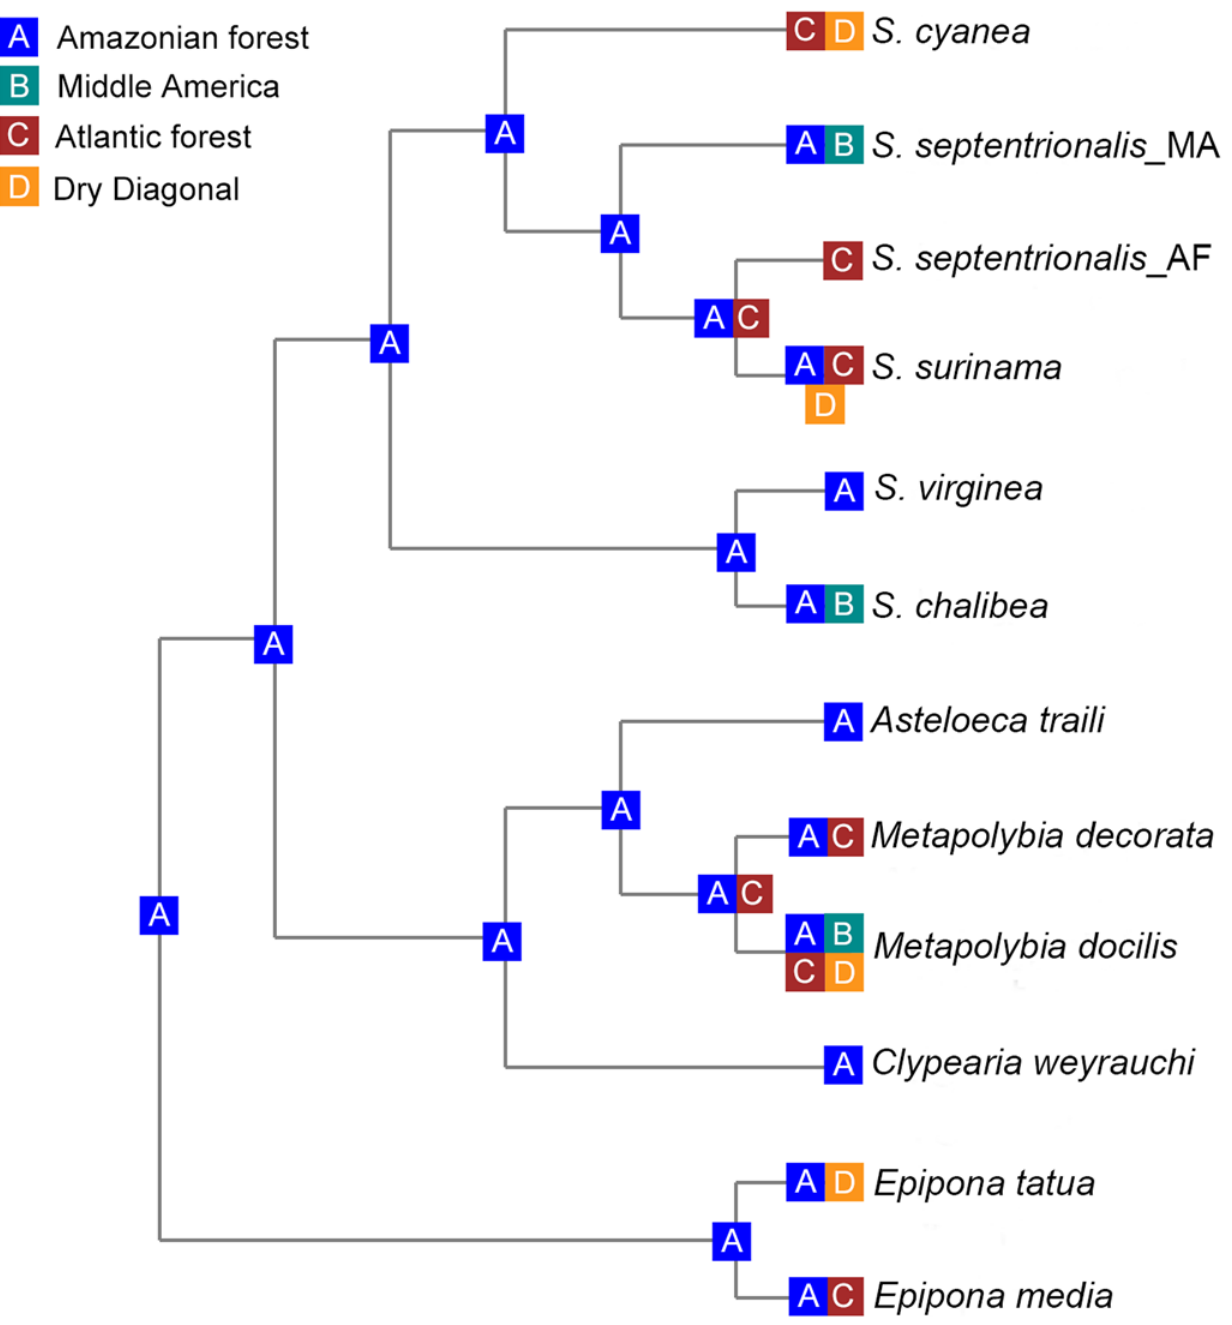
Fig 6. Biogeographical analysis using Bayesian Binary MCMC, showing only the most likely states at each